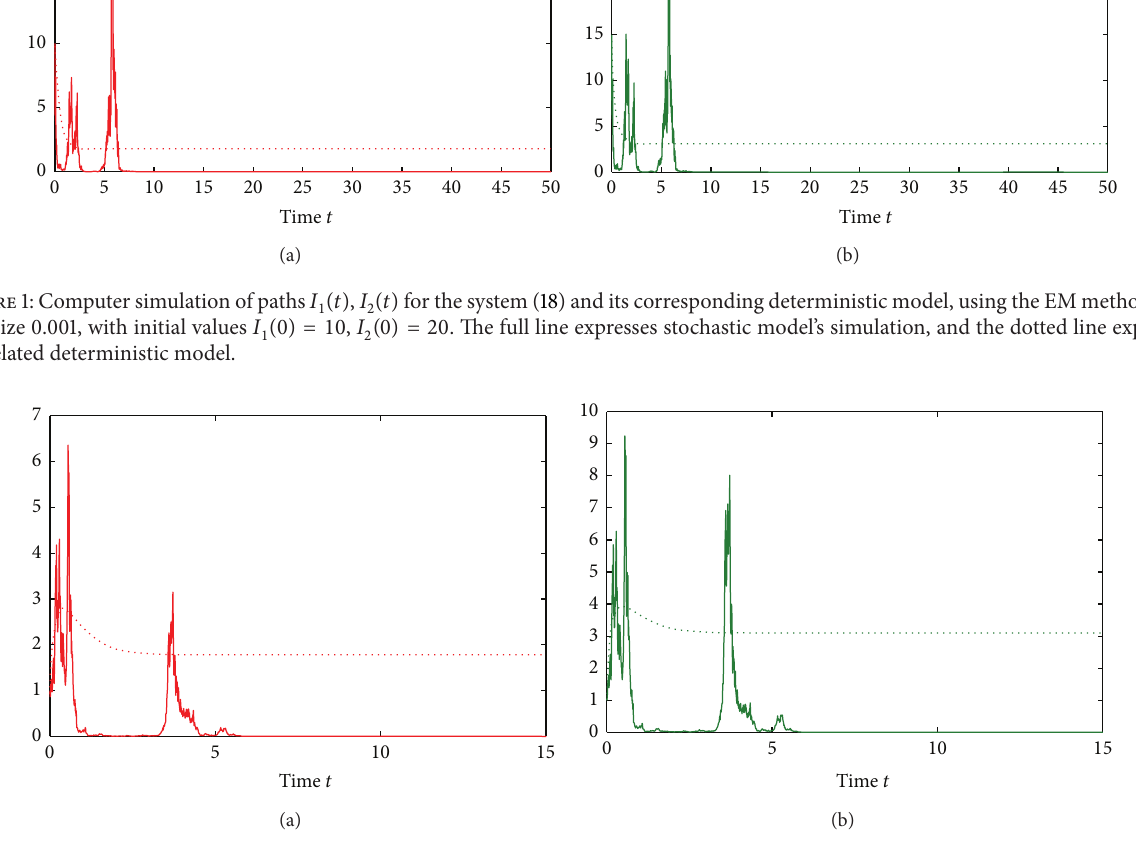
Figure 2: Computer simulation of paths 𝐼 1 (𝑡) , 𝐼 2 (𝑡) for the system (18) and its corresponding deterministic model, using the EM method with step size 0.001, with initial values 𝐼 1 (0) = 1 = 𝐼 2 (0) = 1 . The full line expresses stochastic model’s simulation, and the dotted line expresses the related deterministic model.